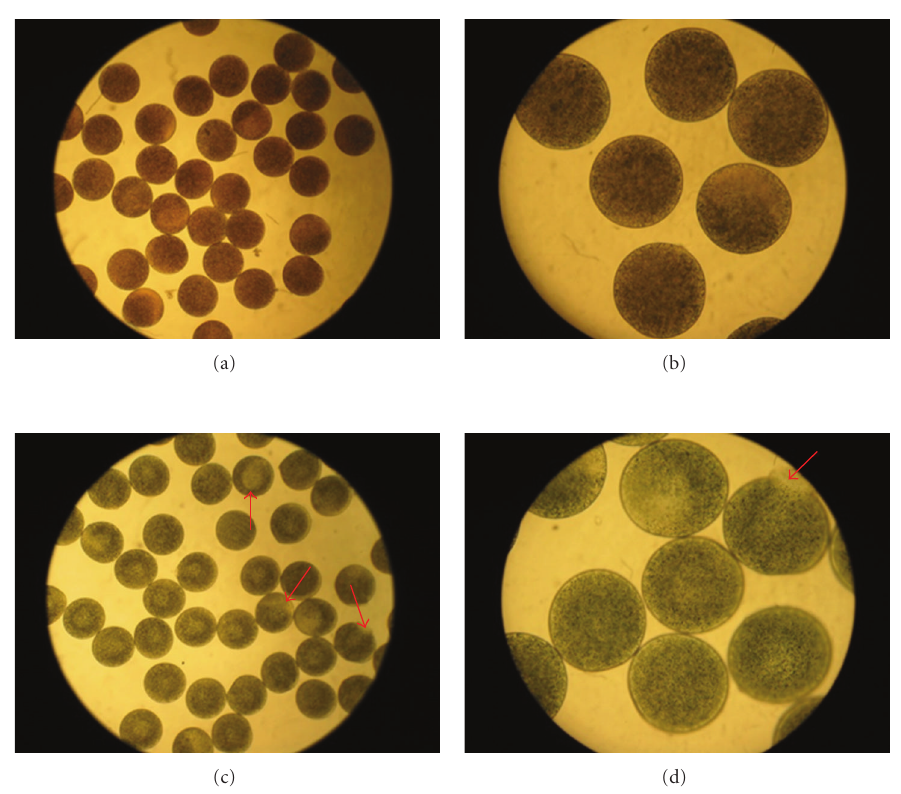
Figure 6: Morphological stability of the GCAC (a), (b), and AC (c), (d) microcapsules containing blue dye after incubation in saline for 6 months. Red arrows indicate defects of the microcapsules. Original magnifications are 35 × (a), (c) or 90 × (b),